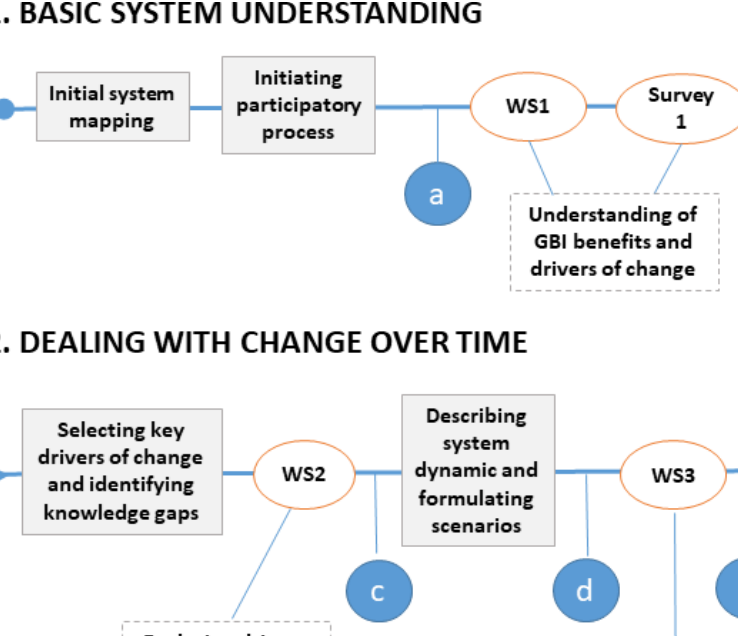
Fig. 2 . The three phases of the participatory resilience thinking process. Grey rectangles are activities by the research team, blue circles are outcomes from the previous activity and that is used in the following one, orange ovals are interactive activities with the research team and stakeholders, white rectangles present the aim of the interactive activity. WS1, WS2, WS3 = first, second, third workshops; GBI - green and blue